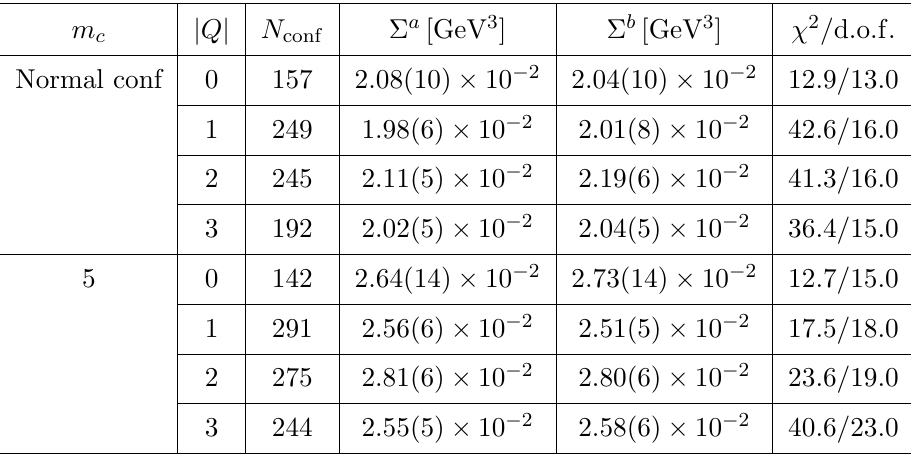
Table 7 . The results of the scale parameters (cid:6) a and (cid:6) b of each topological charge sectors j Q j and k = 1.